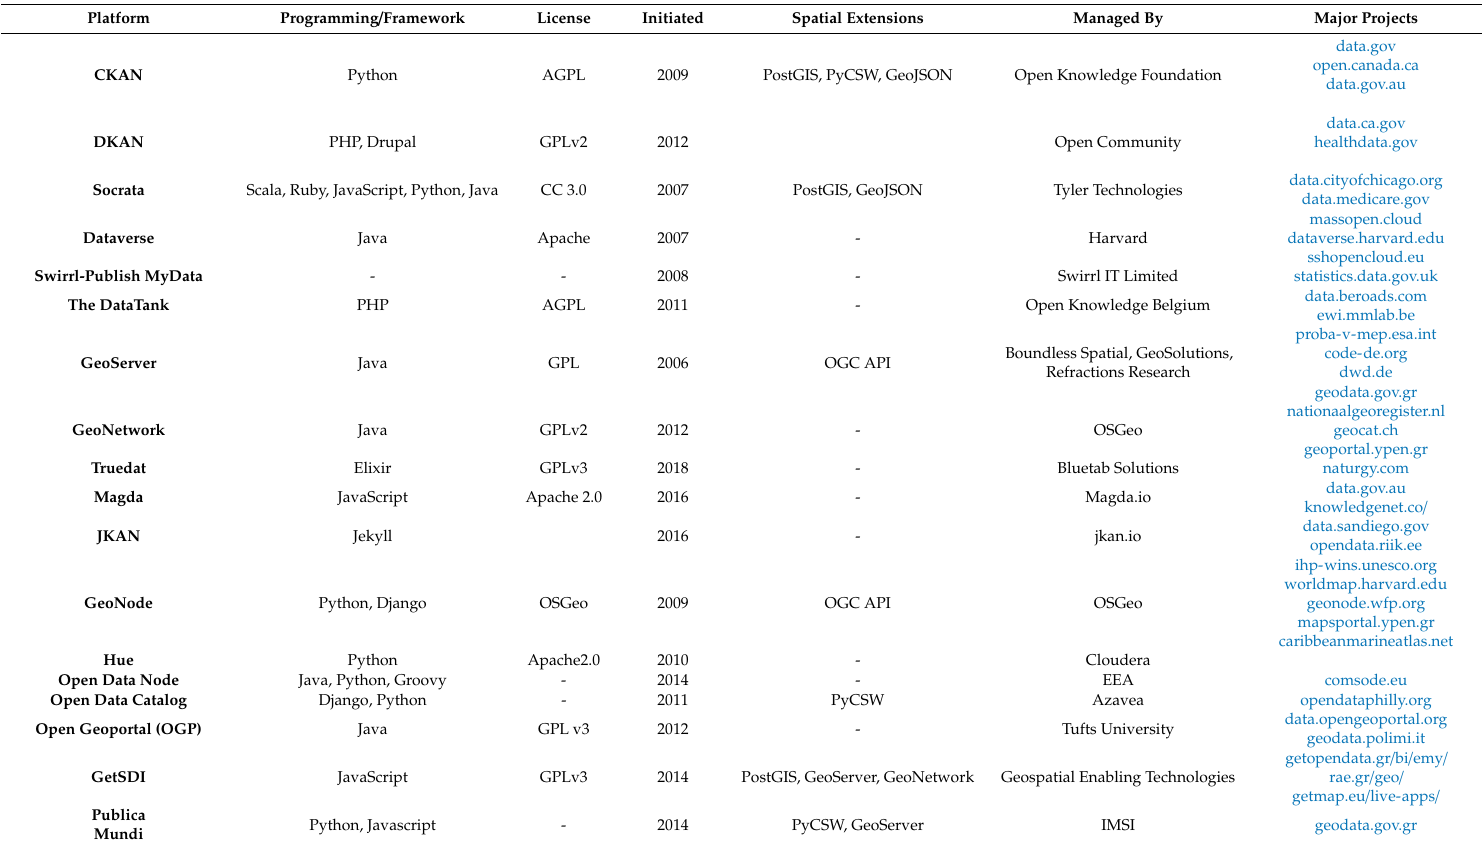
Table 1. Facts and figures of most common open data